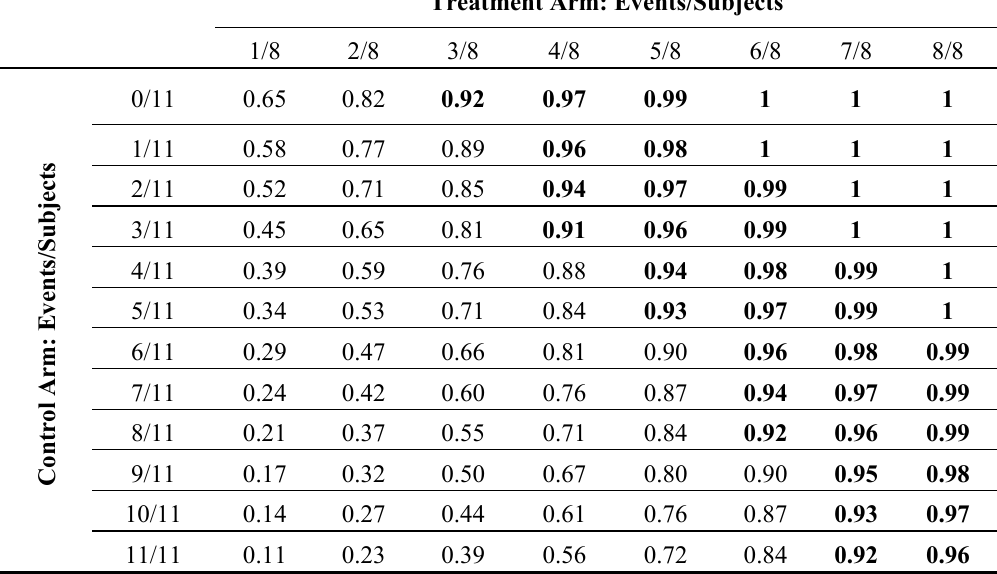
Table 2. An Example of Posterior Probability